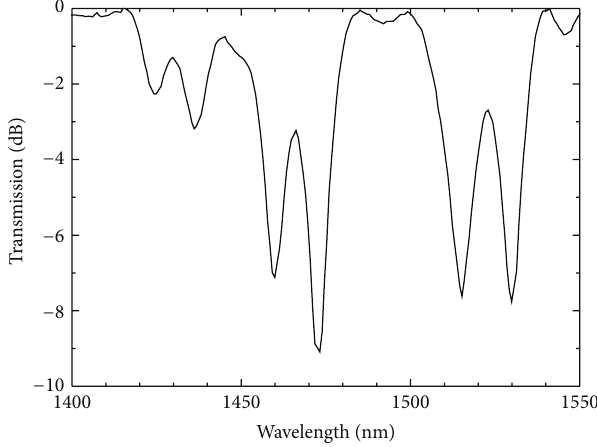
Figure 7: Gratings spectrum with a dual set of resonances ( Λ = 540 𝜇 m).